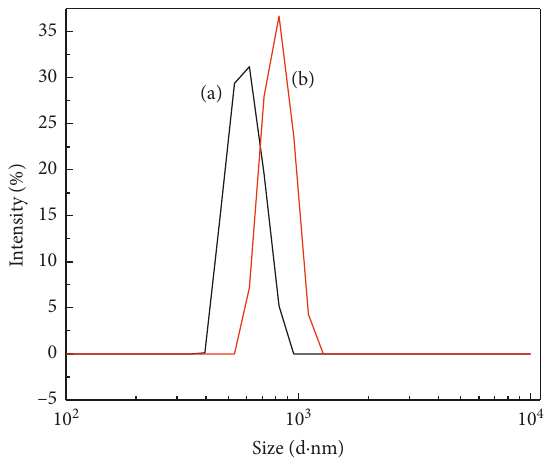
Figure 6: The size distribution of the nanoparticles of (a) SiO